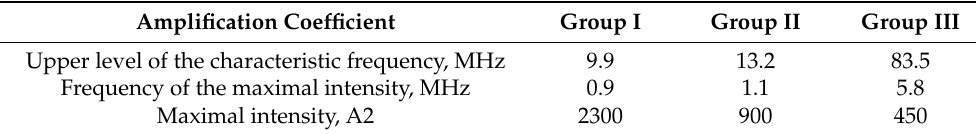
Table 4. Spectral characteristics of the current impulse of streamer corona on the rod model elements (average values).